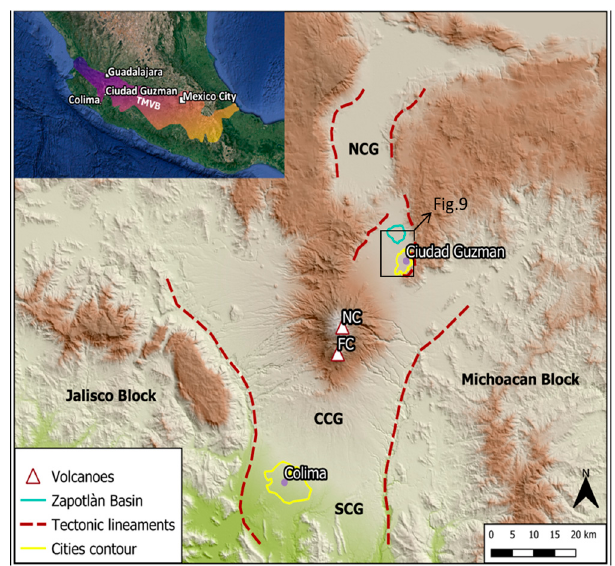
Figure 1. The location of the study area. The upper left Google Earth view localizes the Colima and Ciudad Guzmàn regions (in the Colima Graben area) with respect to the Middle America trench (Central-Western Mexico). The physical map shows the subdivision of the Colima Graben (CG) in the three segments, namely, the Northern Colima Graben (NCG), Central Colima Graben (CCG) and Southern Colima Graben (SCG) between the Jalisco and the Michoacán blocks. Ciudad Guzmàn is located in the South-Eastern part of the NCG, and in the Northern side of the Nevado de Colima (NC) and Fuego de Colima (FC) volcanic structures (the Colima Volcanic Complex-CVC).